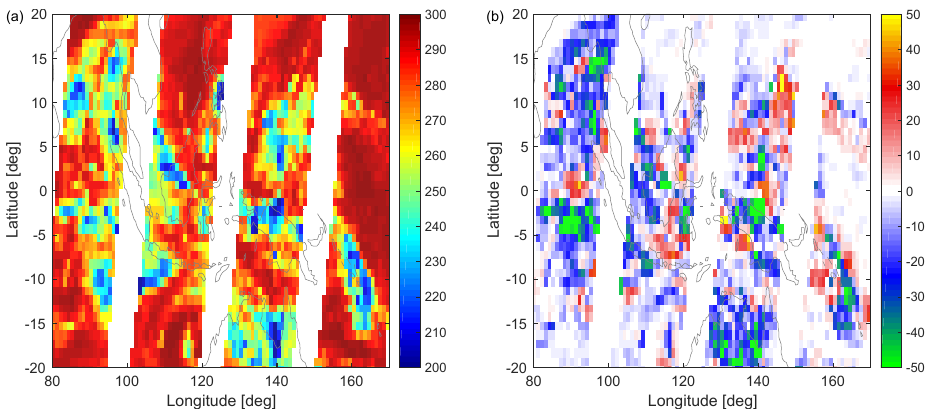
Figure 5. (a) Zoom of left panel in Fig. 4 in the tropical western Pacific region. (b) Zoom of the model biases highlighting that most large biases are due to small spatial offsets of the model clouds. Note that red and blue pixel are often adjacent to each other. For the region shown, the mean bias and standard deviation of (observations – SARTA–TwoSlab) is − 6.1 ±